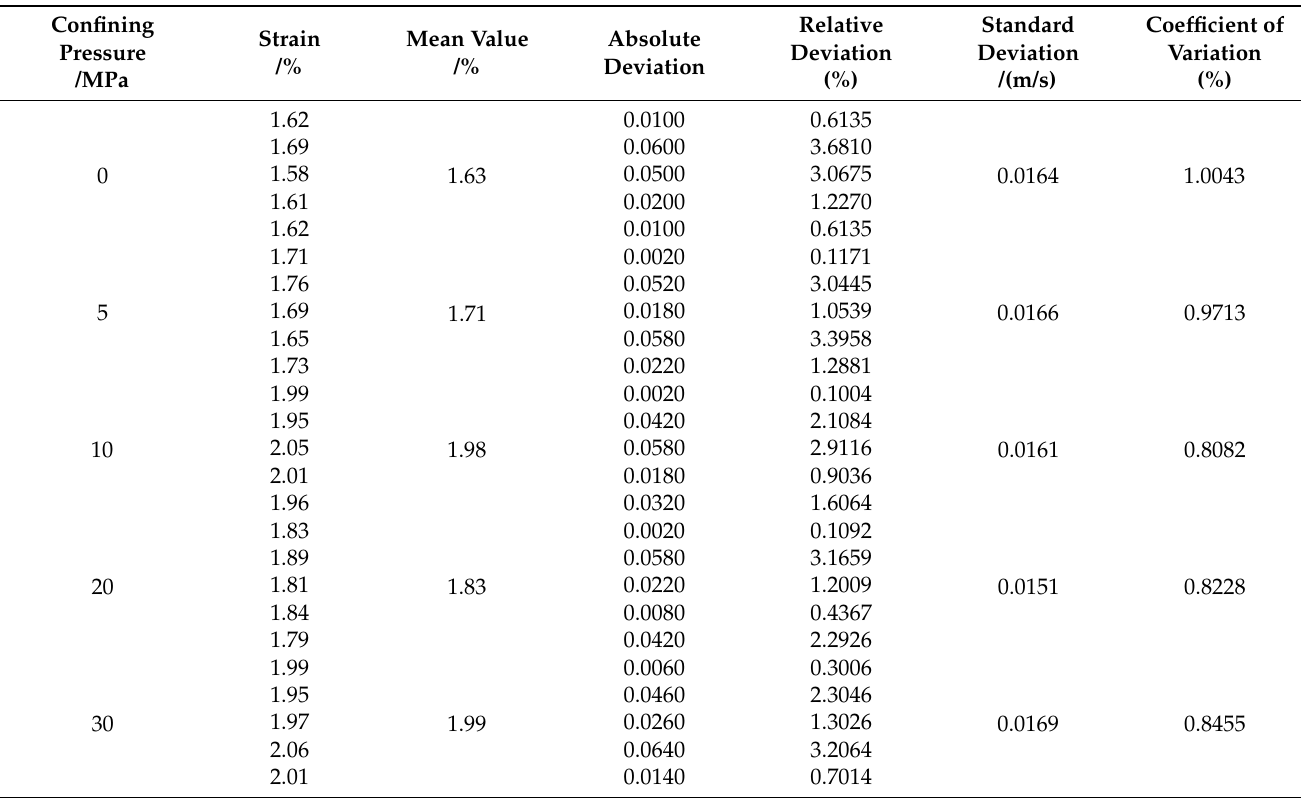
Table 4. Statistical analysis results of strain corresponding with peak stress in CTC